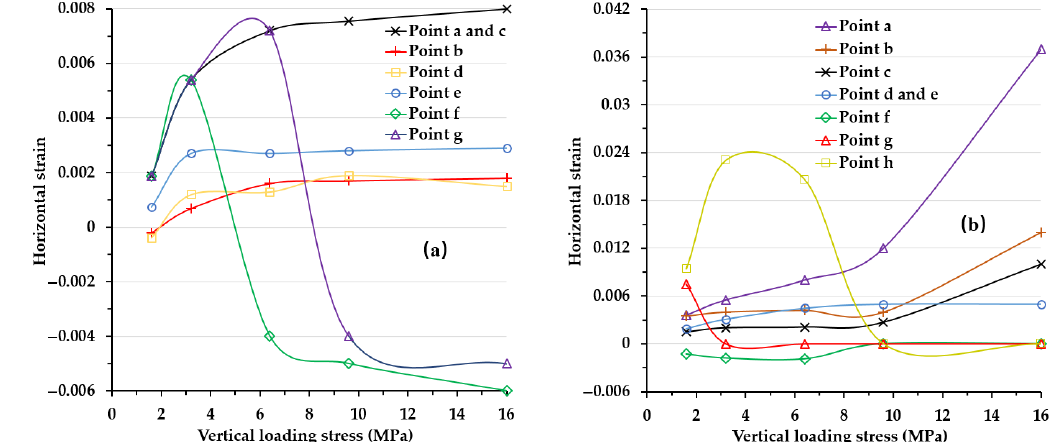
Figure 10. Horizontal strain value of the slope model with one crack at 10°. ( a ) Under different loadings; ( b ) under different loadings and irrigation with 25 mL/min.